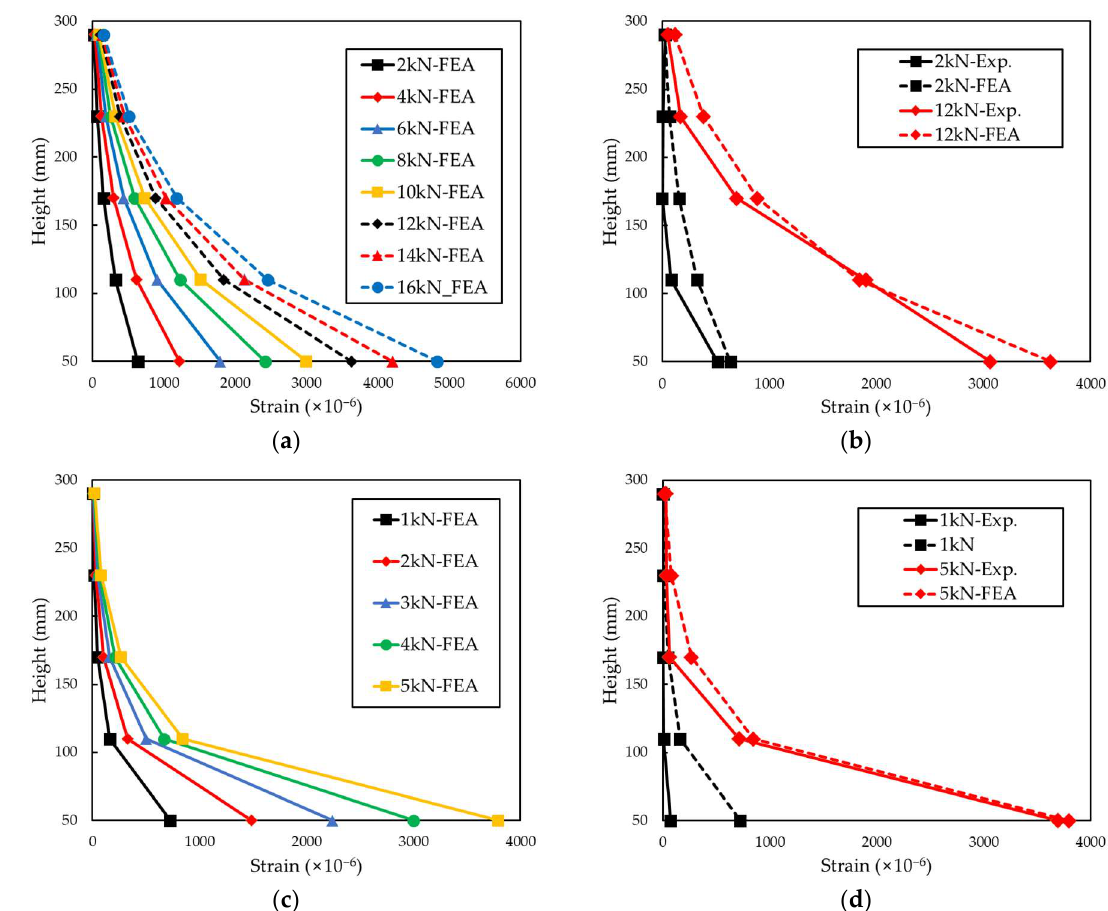
Figure 14. Comparison of tensile strain distribution of P.C and P.G specimen. ( a ) Tensile strain distribution of P.C specimen: FEA results. ( b ) Exp. vs. FEA results. ( c ) Tensile strain distribution of P.G specimen: FEA results. ( d ) Exp. vs. FEA results.